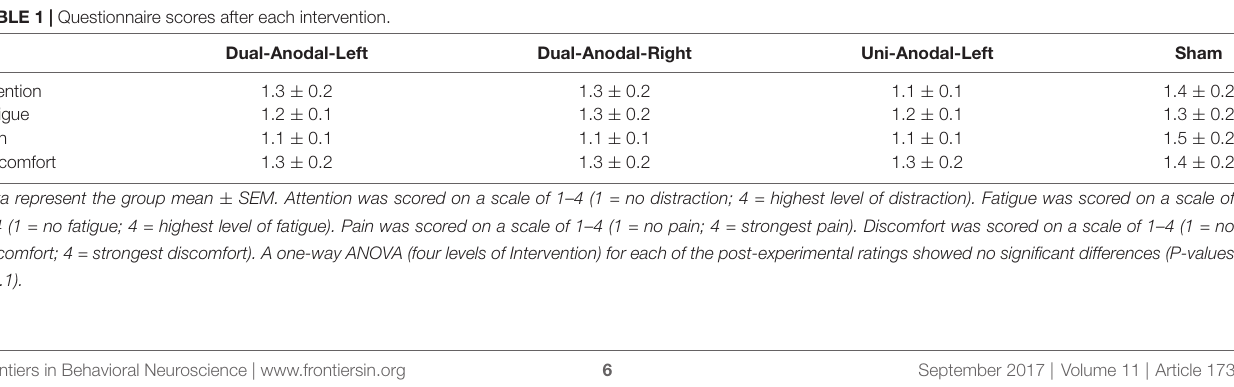
Figure 3D . As expected, EFs in the bilateral PO were symmetric in dual-hemisphere tDCS ( P -values > 0.9), whereas the left PO showed stronger EFs than the right PO in uni-hemisphere tDCS ( t ( 61 ) = 17.56, P < 0.001, d z = 2.23 for peak EF; t ( 61 ) = 38.22, P < 0.001, d z = 4.85 for mean EF). We compared EFs in the PO with EFs in the S1 hand area.